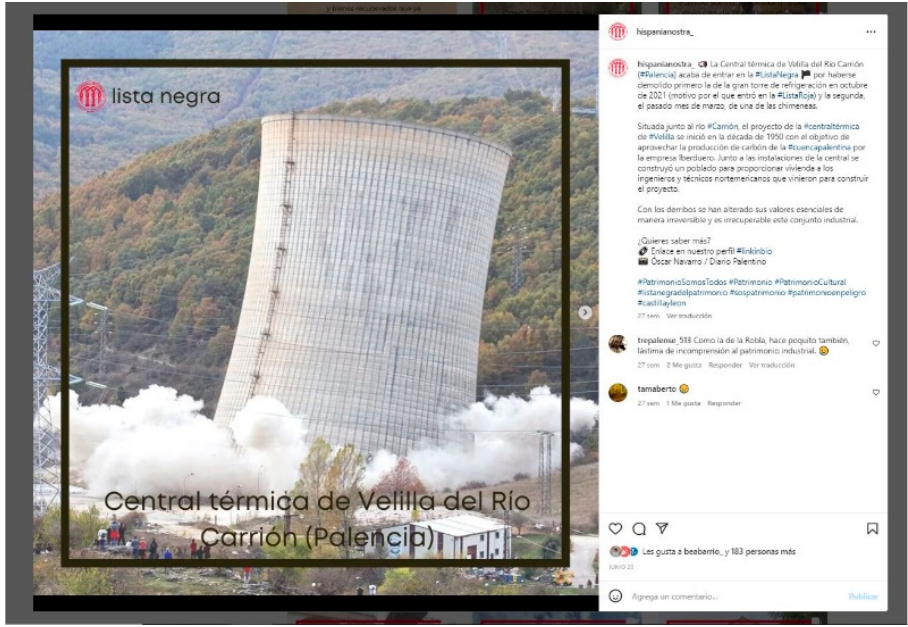
Figure 1. Hispania Nostra’s Instagram post about the demolition of the cooling tower of the Velilla del Río Carrión thermal power plant.